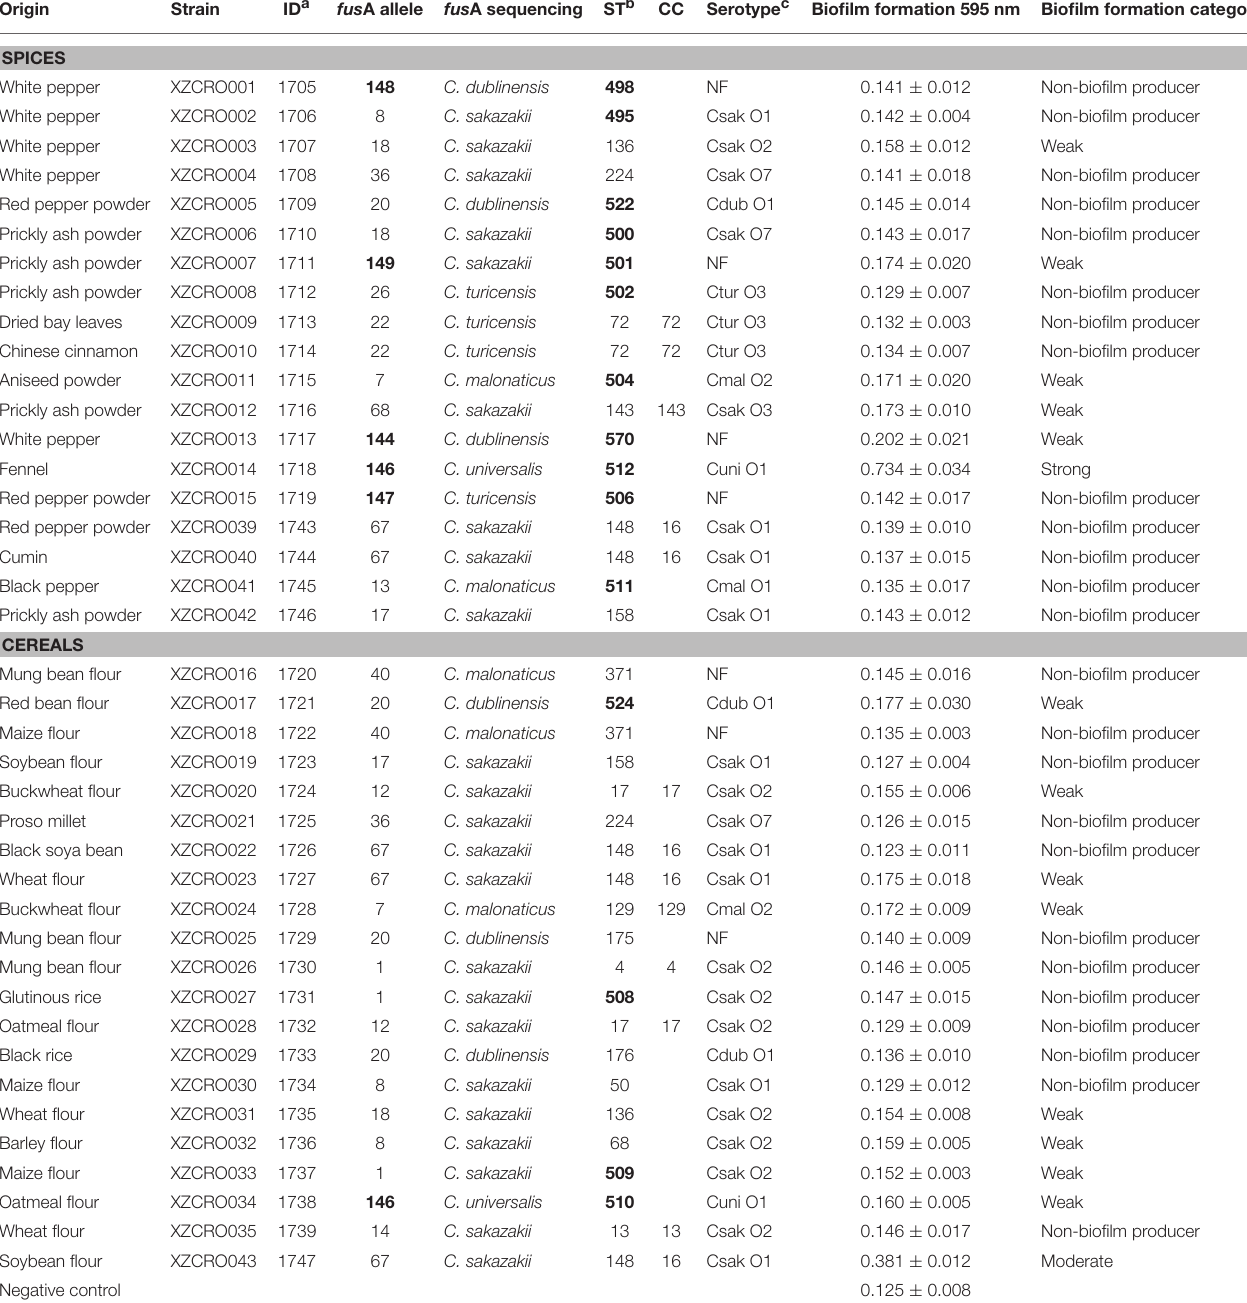
TABLE 1 | Molecular identification and biofilm formation profiles of Cronobacter strains used in this study. Origin